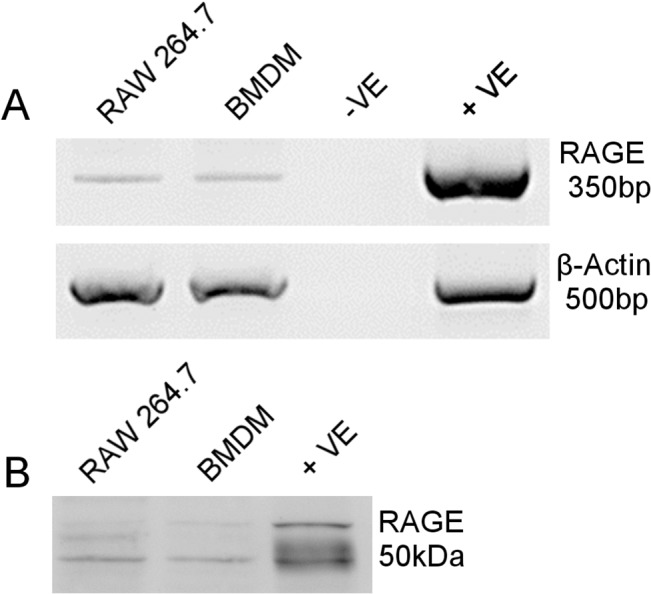
RAGE gene expression of RAW 264.7 macrophages and BMDM.A) Agarose gel electrophoresis of RT-PCR products indicates RAGE band at expected band size of 350 bp and β-actin as reference gene with band size 500 bp. Mouse lung sample used as positive control (+ve), with negative control (-ve) containing water in place of cDNA. B) Western blot for RAGE showing predicted 50 KDa band for RAW264.7 macrophages and BMDM and for positive control (+ve) mouse lung.